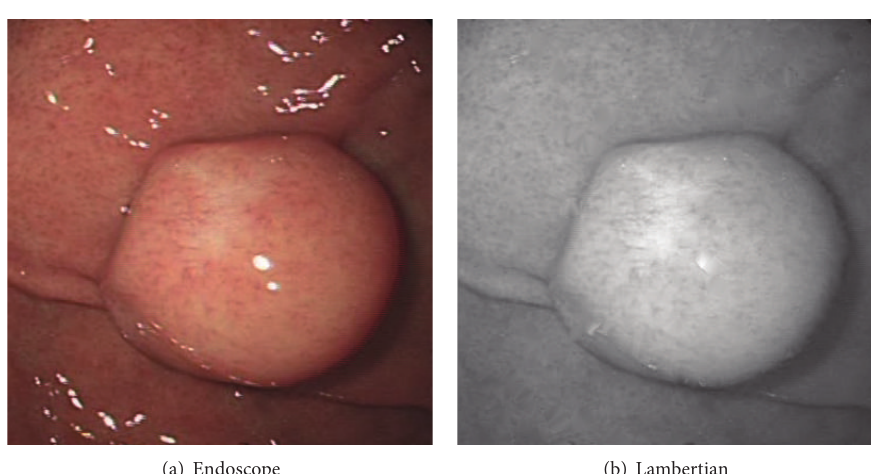
Figure 10: Endoscope image and generating Lambertian